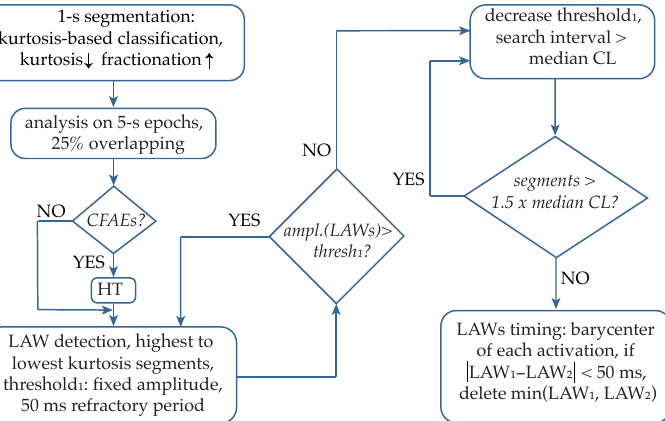
Figure 7. Blocks of the analysis performed by the proposed algorithm. CFAEs: complex fractionated atrial electrograms; HT hyperbolic tangent; LAWs: local activation waves; CL: cycle length.